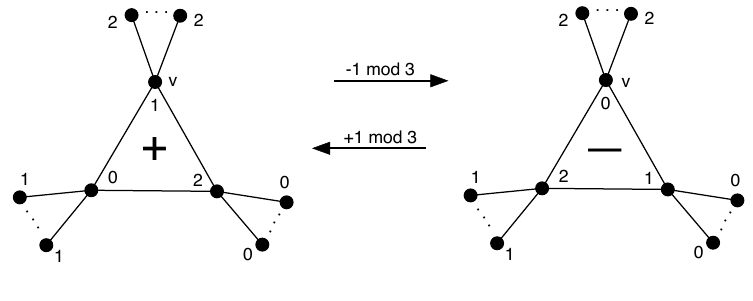
Figure 5: Recoloring signed triangles.